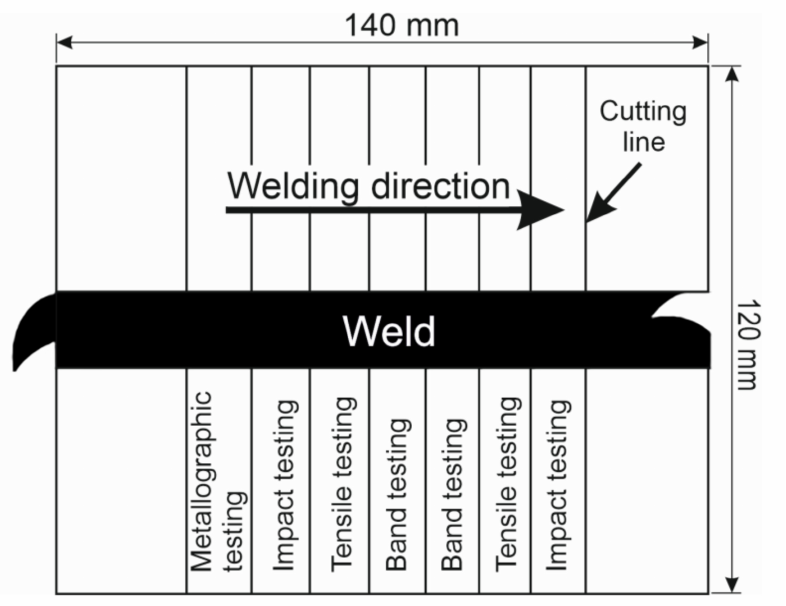
Figure 5. Specimen cutting